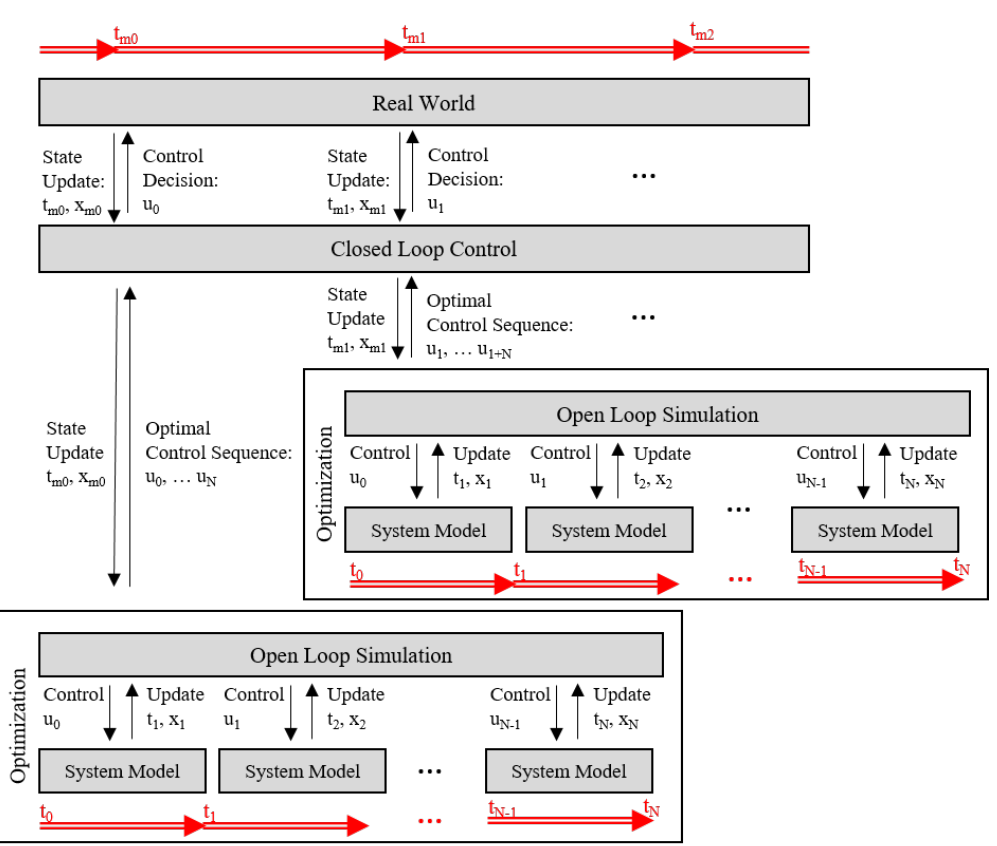
Figure 1. General scheme of Model Predictive Control.